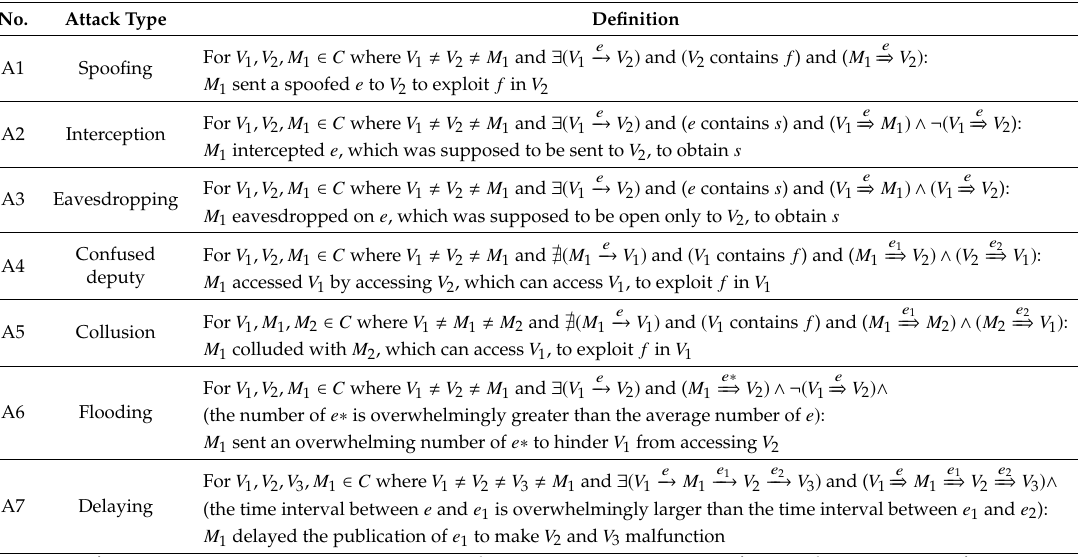
Table 1. Types of Event